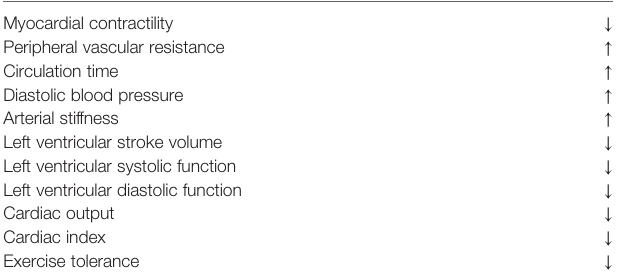
TABLE 3 | Hemodynamic changes in